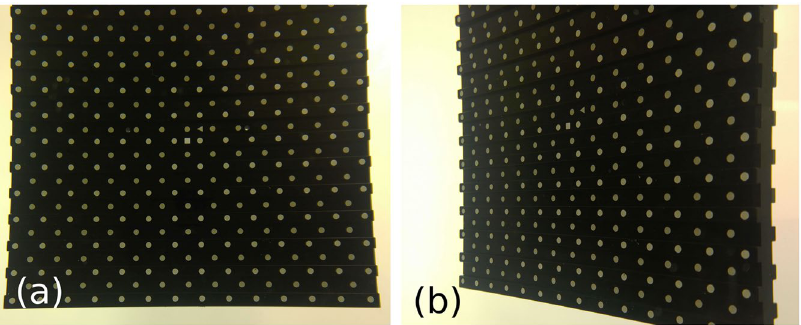
Figure 3. Image of the calibration target (type 22 from LaVision) viewed from two angles. ( a ) From central- bottom camera 3 and ( b ) from the off-axis camera 4. The image shows the optical distortions produced by the lens and by the angled view through the Plexiglas